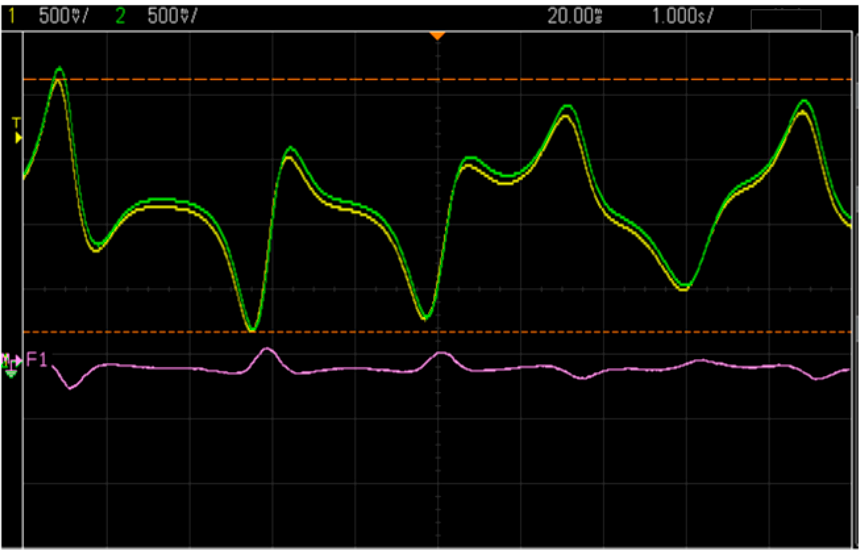
Figure 23. Variables x 2 n and x 2 n with Raspberry Pi. Figure 24 shows the EMG before encryption in the master and after decryption in the slave. The maximum and minimum values of the bio-signals are 0 and 5 V, respectively, and the unit is 1 V/cell. Figure 25 shows the ECG before encryption in the Master and after decryption in the Slave. The maximum and minimum bio-signals are 2 V and 4.5 V, respectively, with unit of 1 V/cell. The figure indicates that the bio-signals before encryption and after decryption remain the same, except for the offset misalignment of the error.